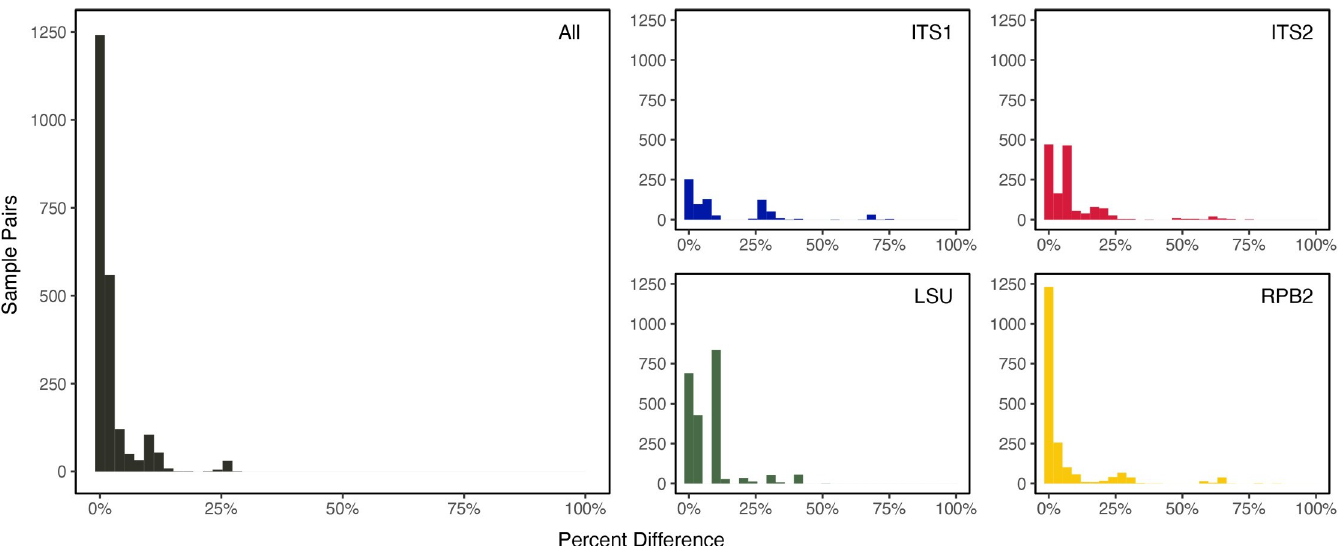
Fig 2. Percent genetic difference among pairwise comparisons of all specimens. Approximately half of all specimen pairs are identical for any given locus, as well as when all four loci are combined, suggesting that asexuality is an important aspect of the B . major life history. The least degree of polymorphism occurs in RPB2 , whereas the most occurs in ITS1, in contrast to observations in other fungal species [28,